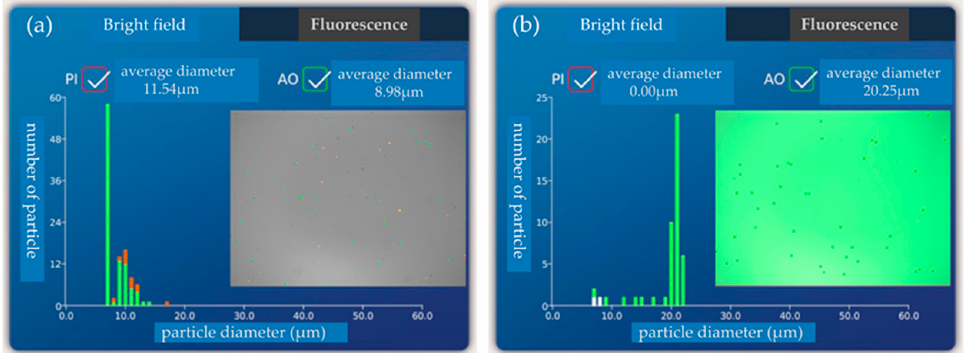
Figure 9. ( a ) 20 μ m particle content test at the target outlet during the first sampling; ( b ) The 20 μ m particle content test at the non-target outlet during the first sampling.